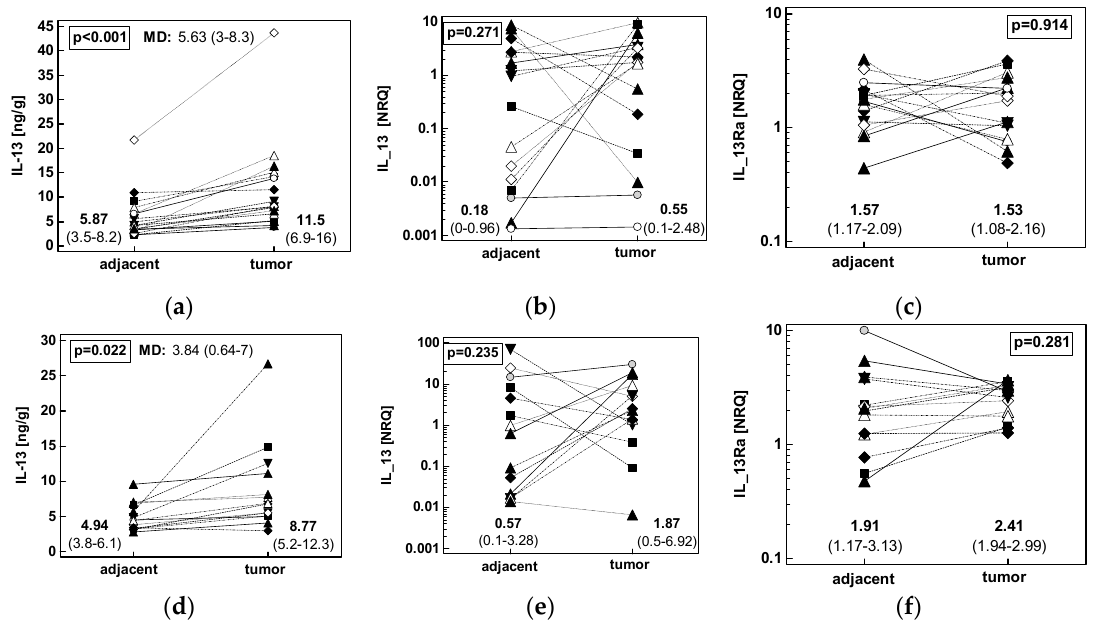
Figure 6. Patients’-matched analysis of tumor and tumor-adjacent tissue expression of: ( a ) IL-13 protein in ESCC ( n = 18); ( b ) IL13 mRNA in ESCC ( n = 16); ( c ) IL13Ra1 mRNA in ESCC ( n = 16); ( d ) IL-13 protein in GC ( n = 14); ( e ) IL13 mRNA in GC ( n = 14); ( f ) IL13Ra1 mRNA in GC ( n = 14). Data were analyzed as logs using t -test for paired samples and presented as geometric means with 95% confidence interval ( CI ). Mean difference in protein concentration (MD) between groups is accompanied by 95% CI . Transcriptomic data are presented as normalized relative quantities (NRQ). CRC, colorectal cancer; ESCC, esophageal squamous cell carcinoma; GC, gastric adenocarcinoma. Fold-change in IL-13 protein concentration and expression of IL13 and IL13Ra1 transcripts was comparable in CRC and upper GIT cancers (Figure